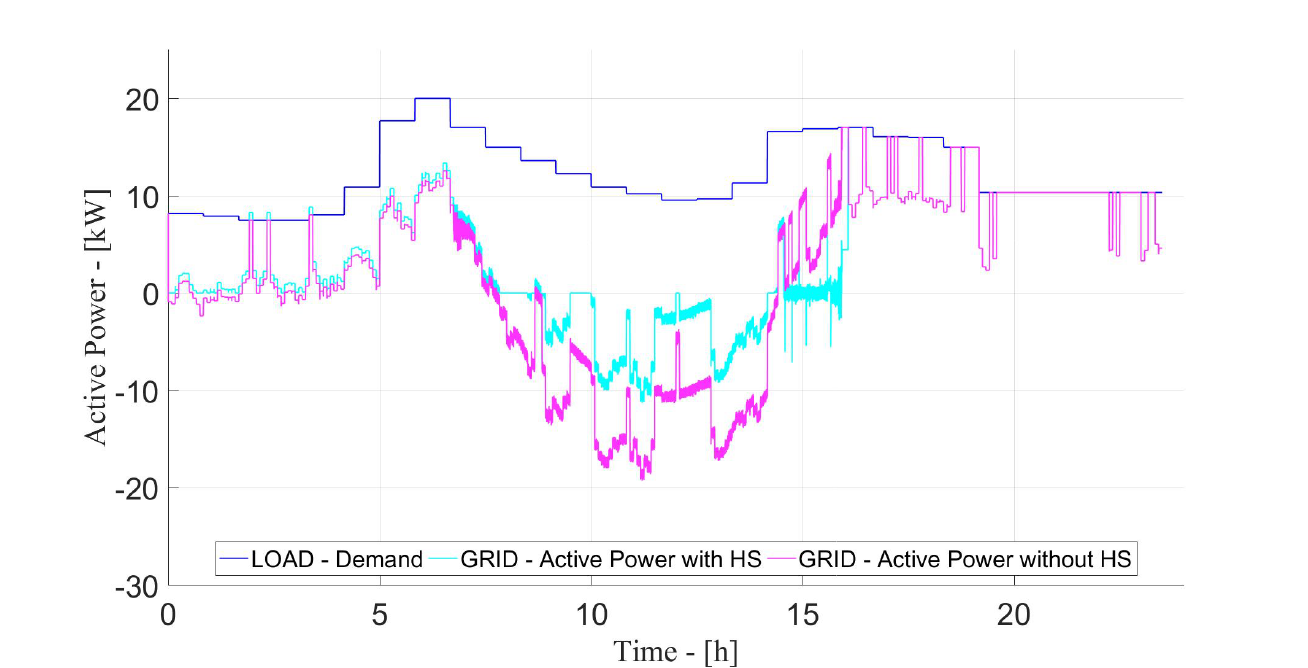
Figure 11. Integrated System Simulation. Confronting performance of the system with/without hydrogen-based system. Active power exchange with the grid in